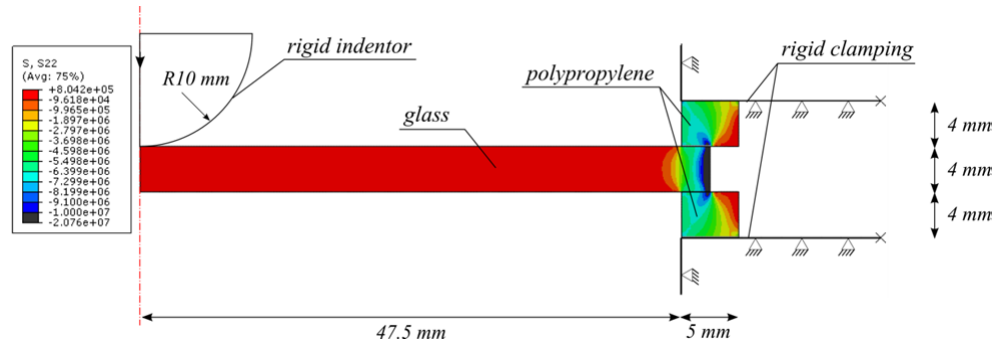
Fig. 11 Axisymmetric representation of numerical model for drop weight impact on glass specimen with boundary conditions and compressive clamping; contours of initial stress field in axial direction.